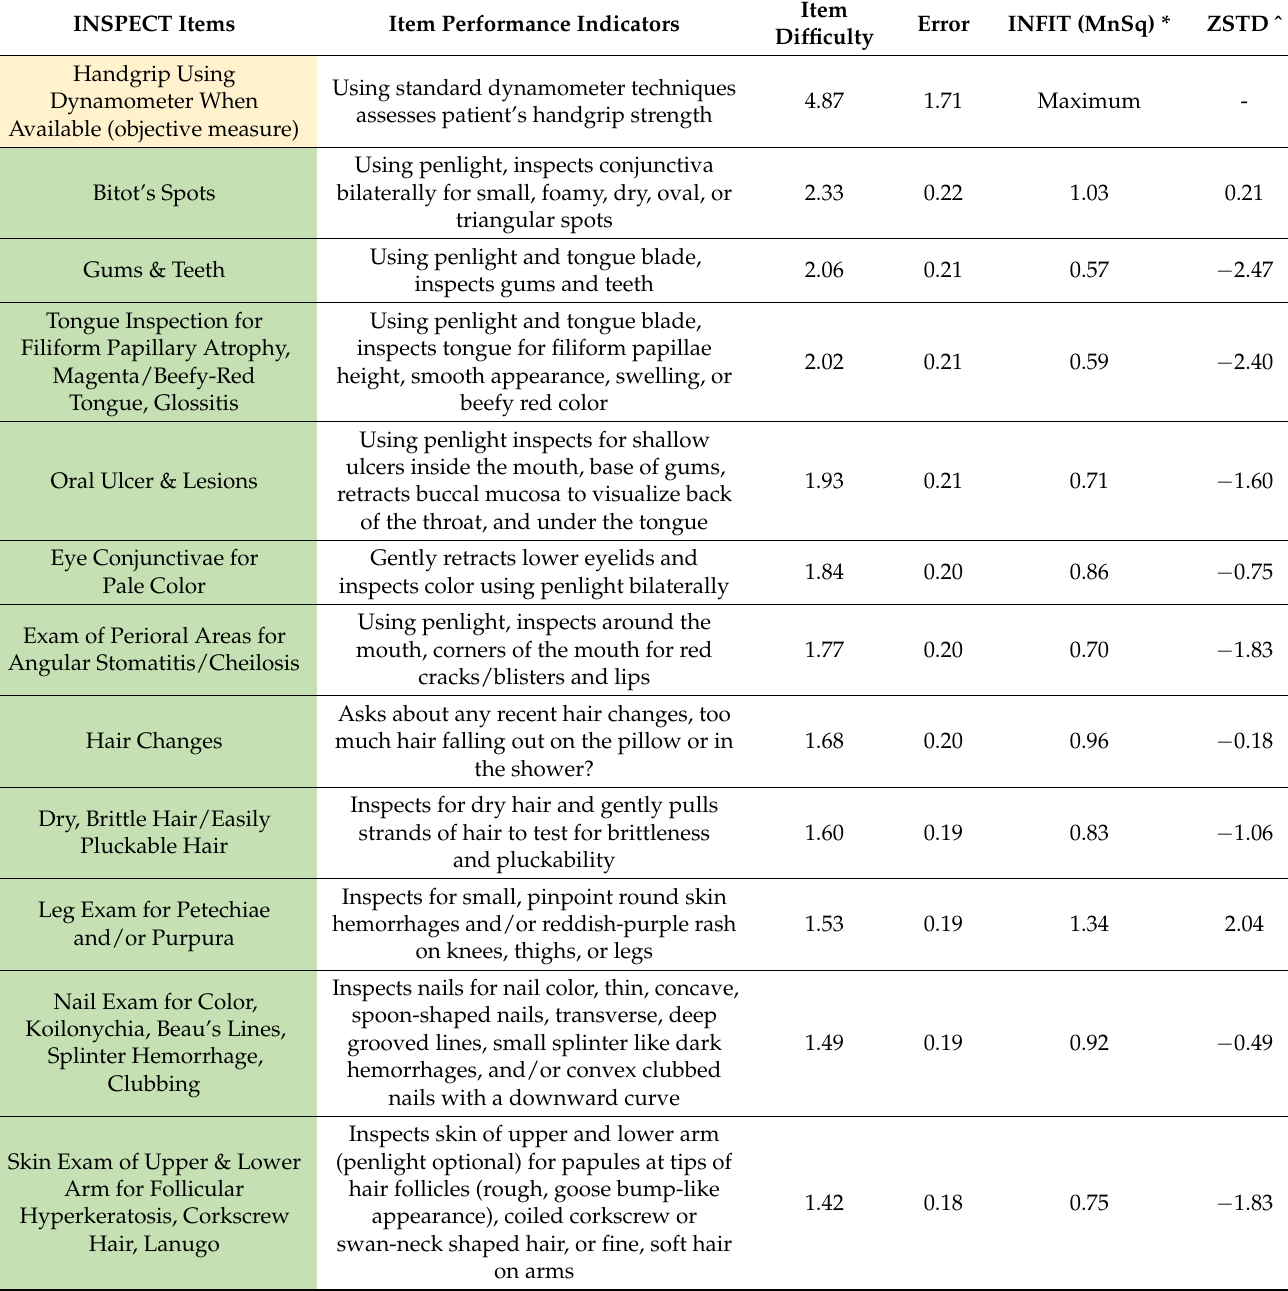
Table 3. Hierarchy of the INSPECT Item